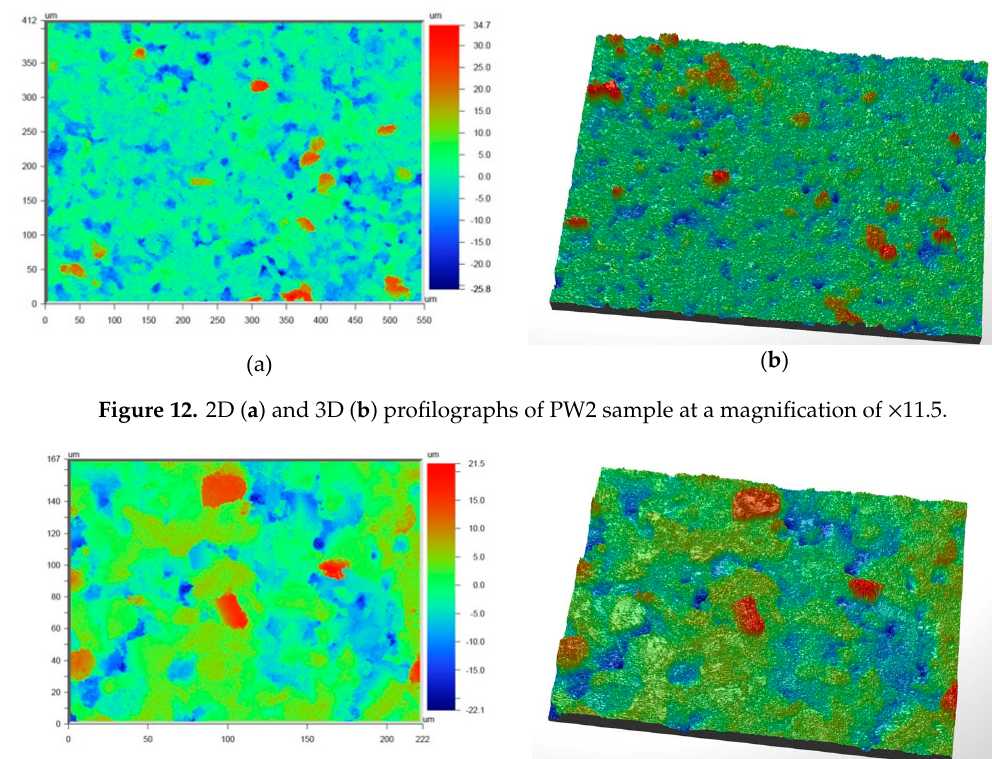
Figure 11. 2D ( a ) and 3D ( b ) profilographs of PW2 sample at a magnification of ×2.9.